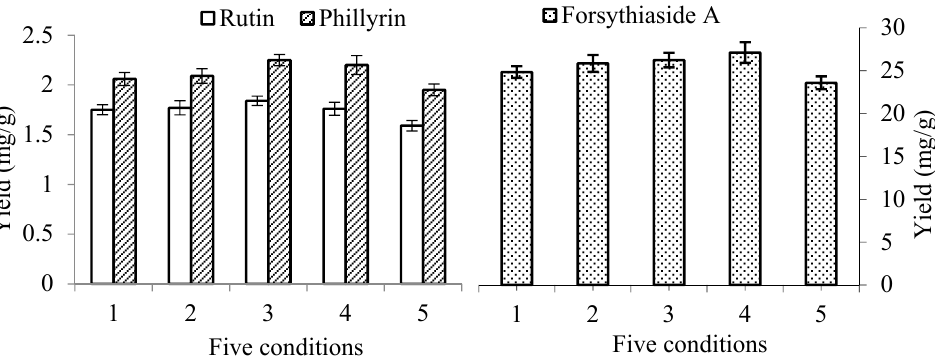
Figure 3. Effect of different conditions on the extraction yields of forsythiaside A, rutin and phillyrin when acetic acid was added to the solvent. The value of forsythiaside A is shown on the secondary y -axis on the right. Condition 1: 50% ethanol as solvent, ultrasonic power 200 W, temperature 30 °C; Condition 2: 50% ethanol + 2% acetic acid as solvent, ultrasonic power 200 W, temperature 30 °C; Condition 3: 50% ethanol + 5% acetic acid as solvent, ultrasonic power 200 W, temperature 30 °C; Condition 4: 50% ethanol + 5% acetic acid as solvent, ultrasonic power 200 W, temperature 50 °C; Condition 5: 50% ethanol + 5% acetic acid as solvent, ultrasonic power 100 W, temperature 30 °C.